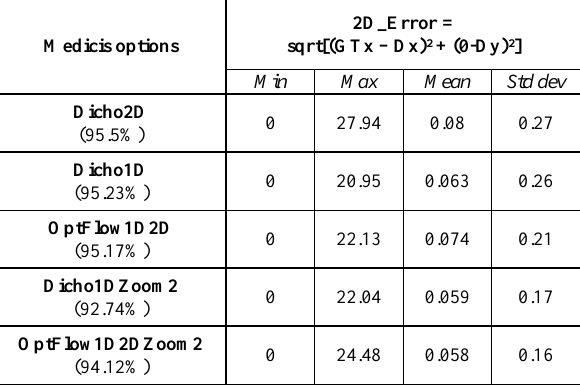
Table 1: Medicis_V11.0 2D_Error statistics obtained on Bergerie1. Dicho2D corresponds to a 2D search at pixel and sub-pixel steps, and to dichotomy